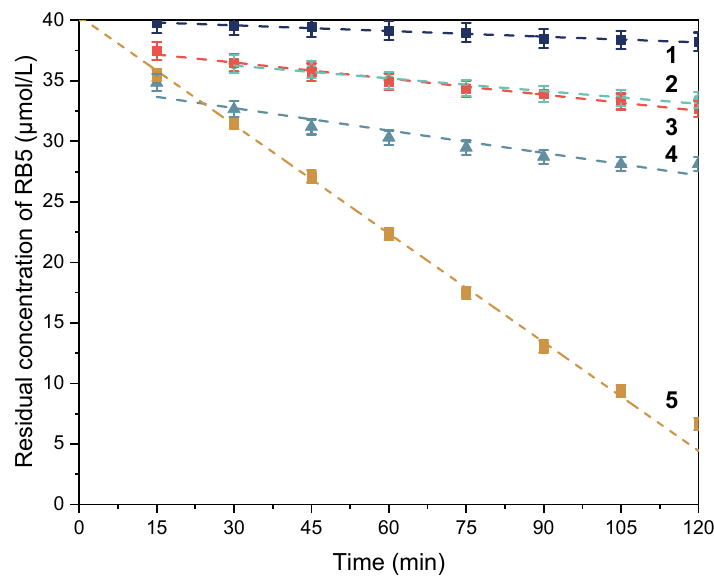
Figure 5. Degradation kinetics of RB5 catalyzed by Fenton polymer composites ( 1 ) PP- g -MA/APTES/F2 (65/35), ( 2 ) PP- g -MA- g -PEO600/APTES/F2 (65/35), ( 3 ) PP- g -MA/F2 (65/35), ( 4 ) PP- g -MA- g -PEO1000/APTES/F2 (65/35) and ( 5 ) F2 for comparison. The composites PP- g -MA/F2 (65/35), PP- g -MA/APTES/F2 (65/35) and PP- g